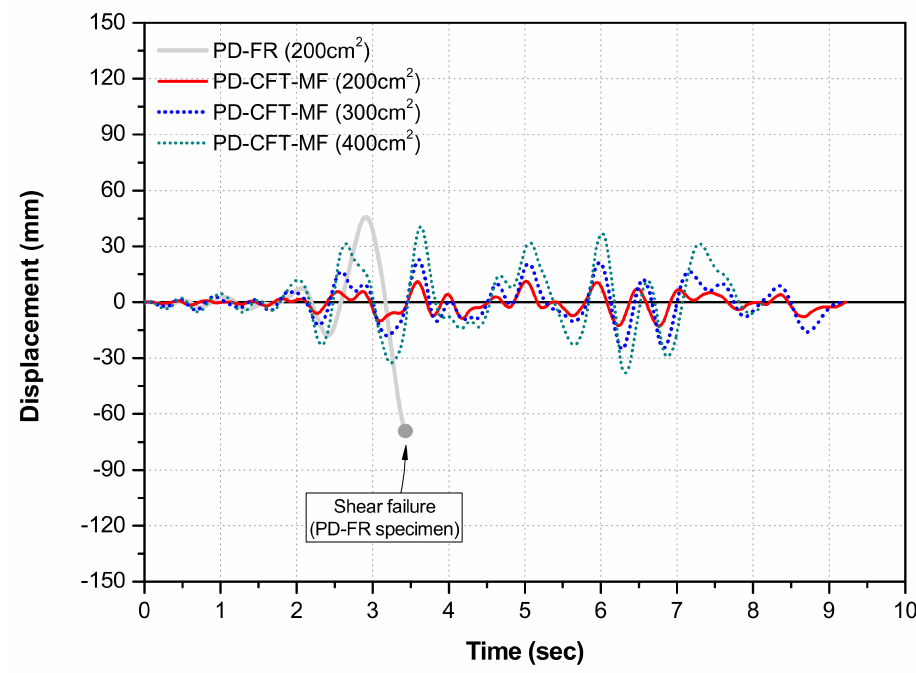
Figure 19. Comparison of seismic response displacement-time hysteresis curves (first